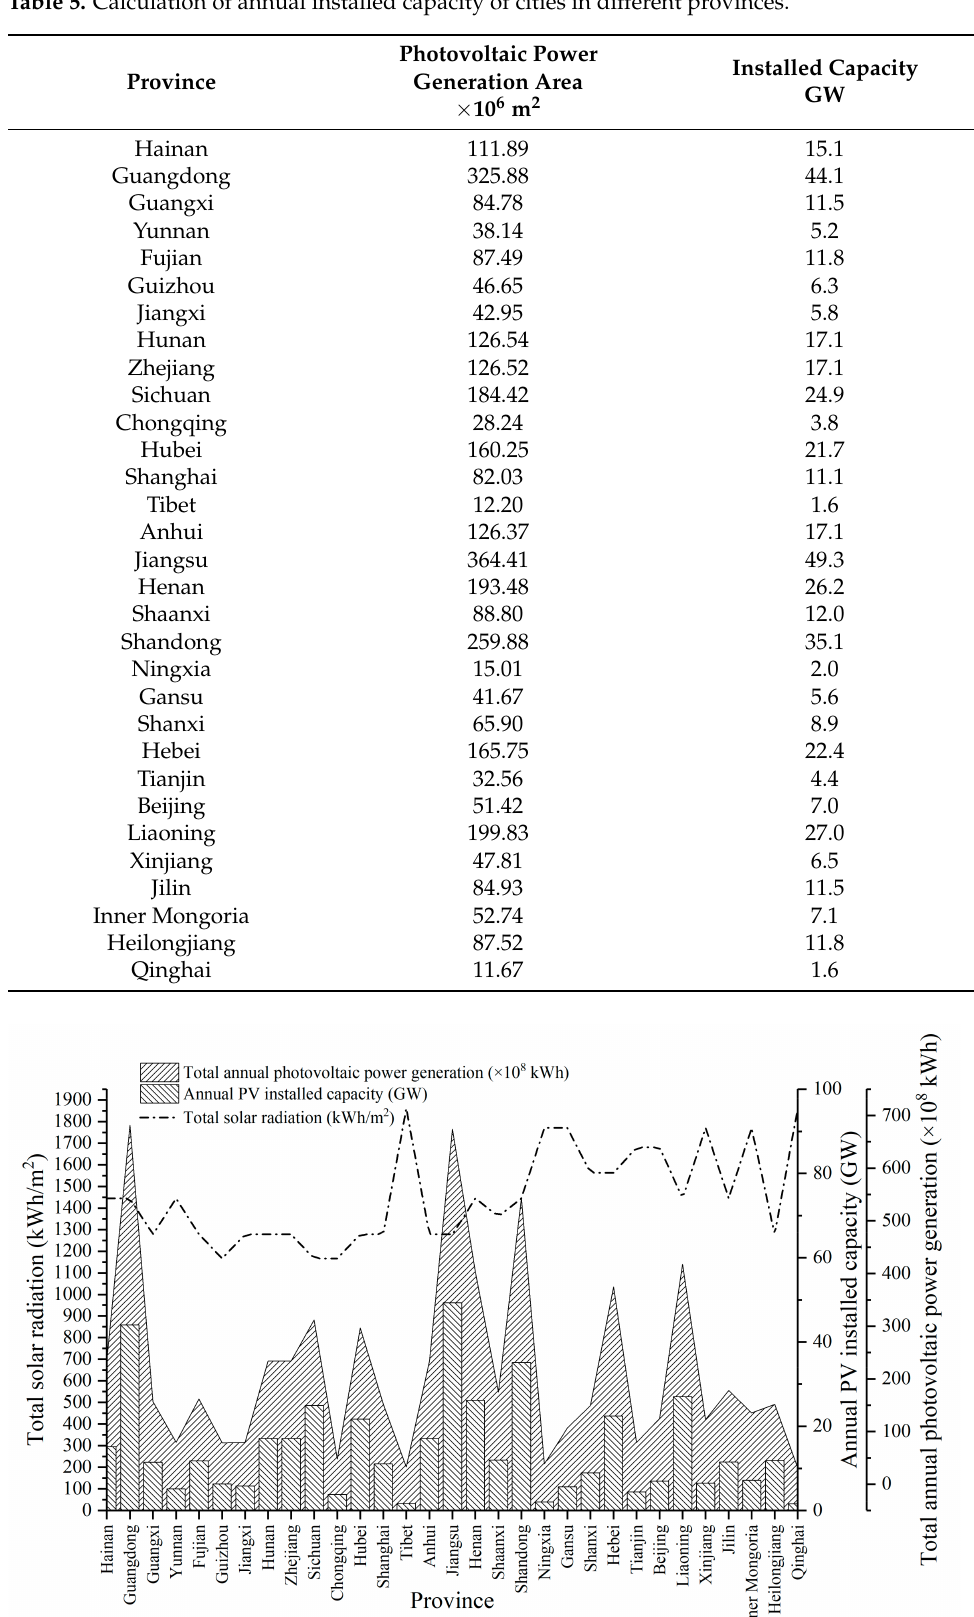
Table 5. Calculation of annual installed capacity of cities in different provinces.